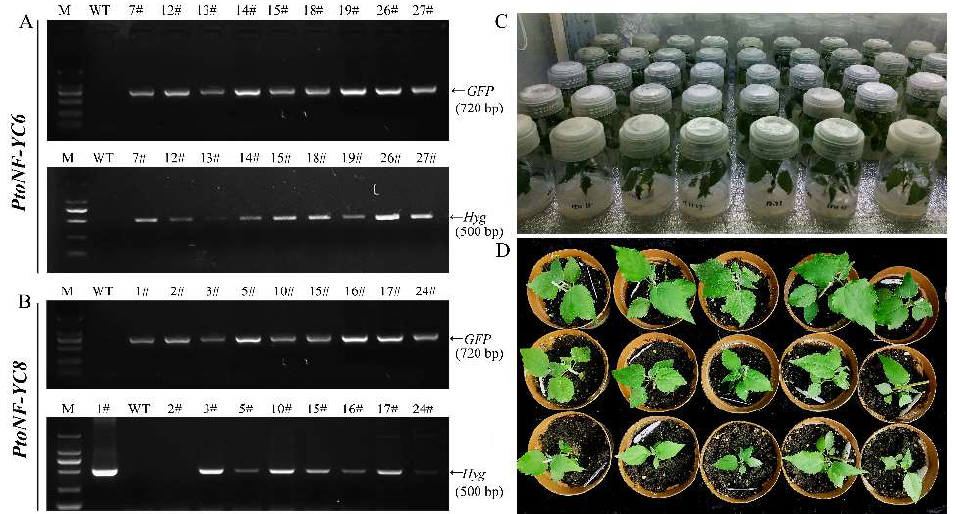
Figure 7. PCR identification and propagation of PtoNF-YC6 and PtoNF-YC8 transgenic P. tomentosa . ( A ) Identification of PtoNF-YC6 transgenic lines. ( B ) Identification of PtoNF-YC8 transgenic lines. ( C ) Transgenic plant propagation. ( D ) The transgenic plants transplanted into soil in greenhouse.